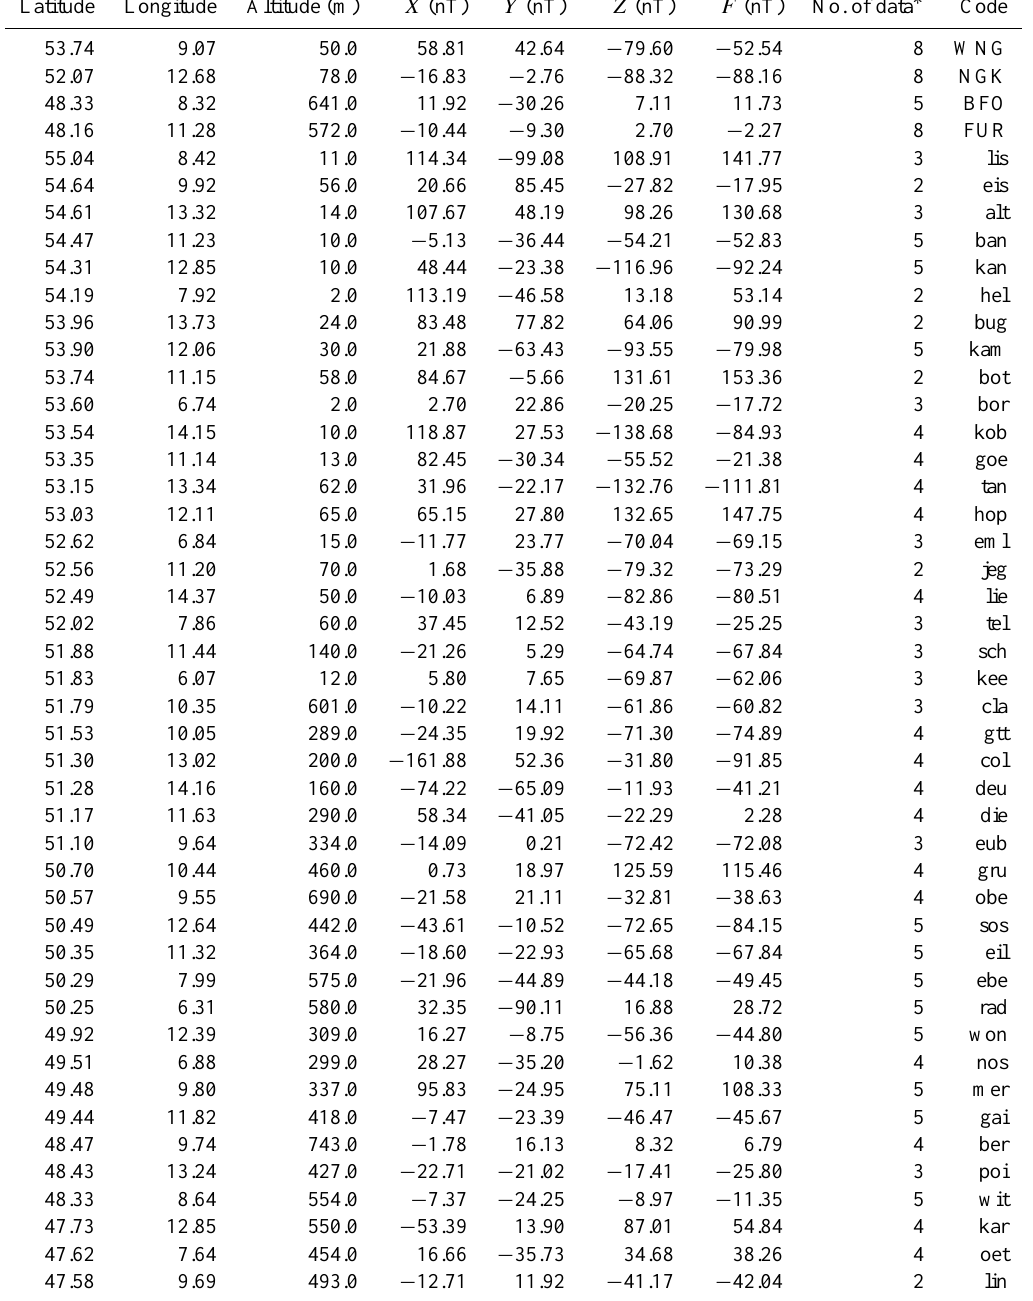
Table 4. Observatory and repeat station lithospheric anomaly values for Germany with magnetospheric correction.